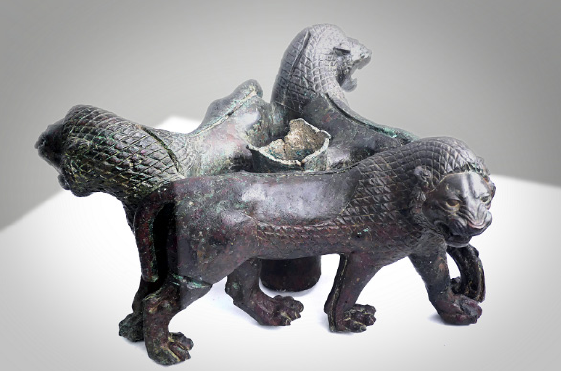
Figure 24. Tripod base with three lion figurines (IMN old inv. no. PT5 642); bronze utensil; Treas- ury (Hall 38), Persepolis (mod. Iran); Achaemenid, ca. 5th cent. BCE [photography by Linda Tobey, ©2018, all rights reserved].